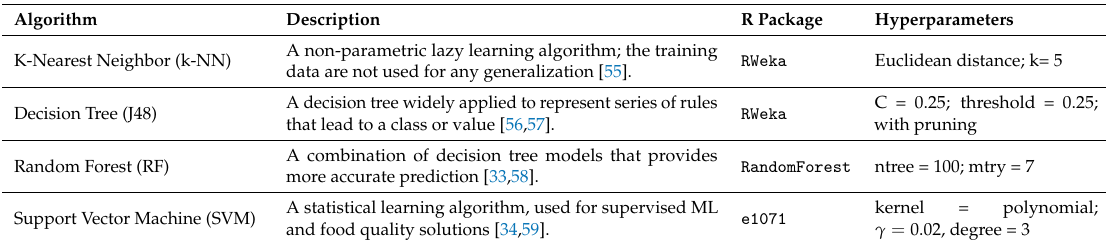
Table 3. Machine learning algorithms used in the experiments and corresponding R packages. Algorithm